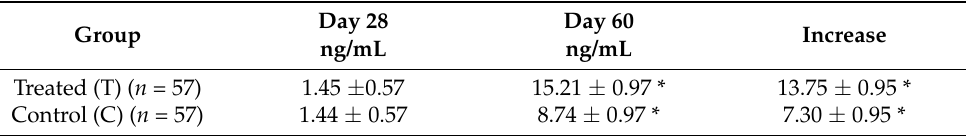
Table 3. Change in PAG concentrations (ng/mL) (mean ± SE) in GnRH-treated (T) and in the control (C) of pregnant buffalo cows at risk of low embryo survival.